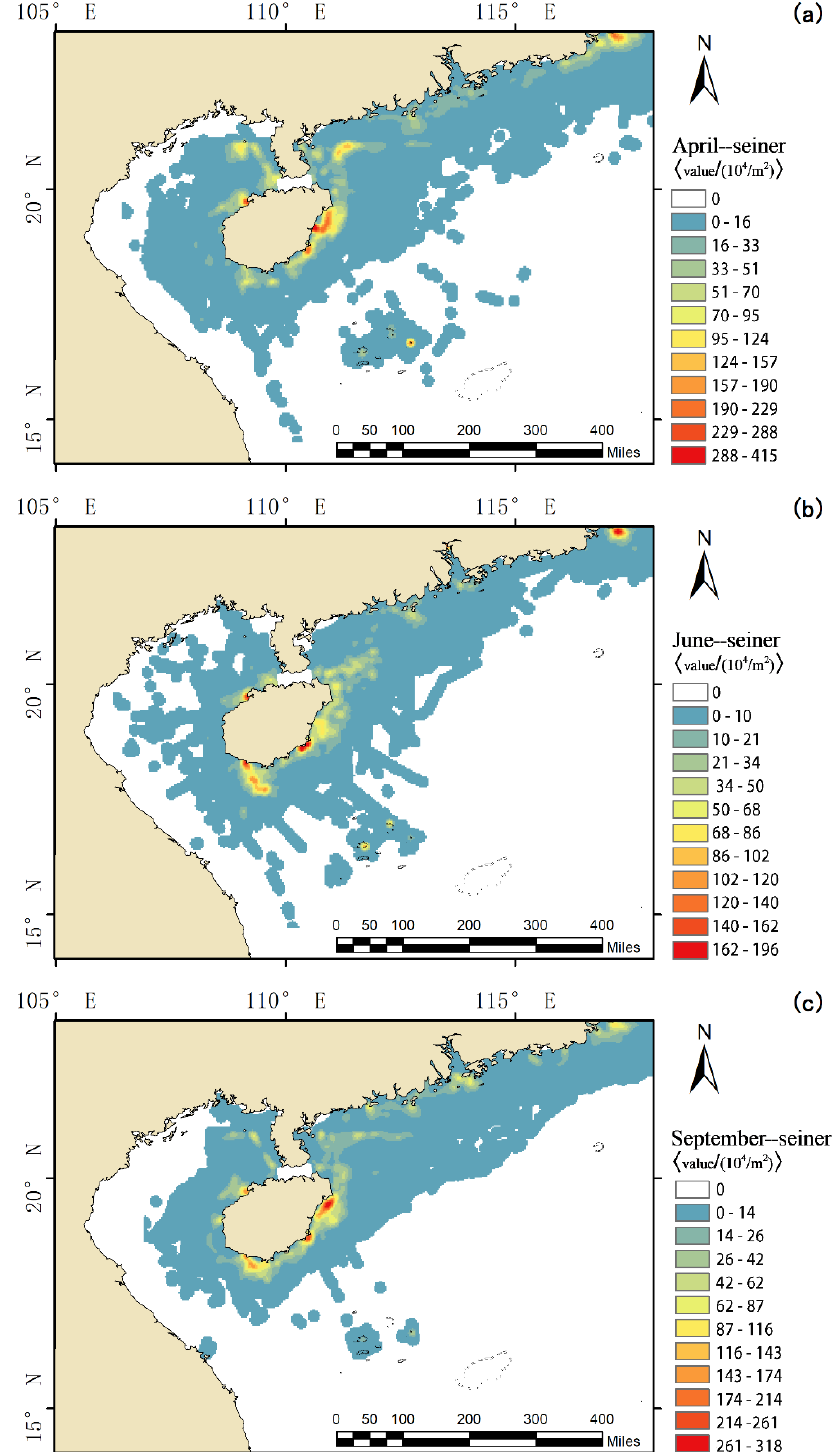
Figure 16. Nuclear density analysis chart of Chinese seiners in April ( a ), June ( b ) and September ( c ). As can be seen from Figure 14, the active range and hotspot areas of trawlers varied significantly with the seasons. In April, the active hotspots of trawlers were mainly distributed in the coastal waters of Hainan Island and Guangdong Province, especially the northwestern seas of Hainan Island and the eastern seas of Leizhou Peninsula. In June, the area was closed to fishing, and the number of vessels and the scope of fishing